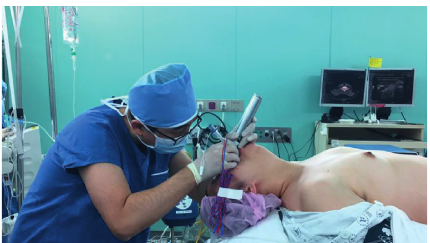
Figure 3: Prior to intubation, a pillow was placed beneath the neck for neck extension to avoid tube displacement during patient positioning. Table 1: Clinicopathological characteristics and surgical outcomes of the patients.